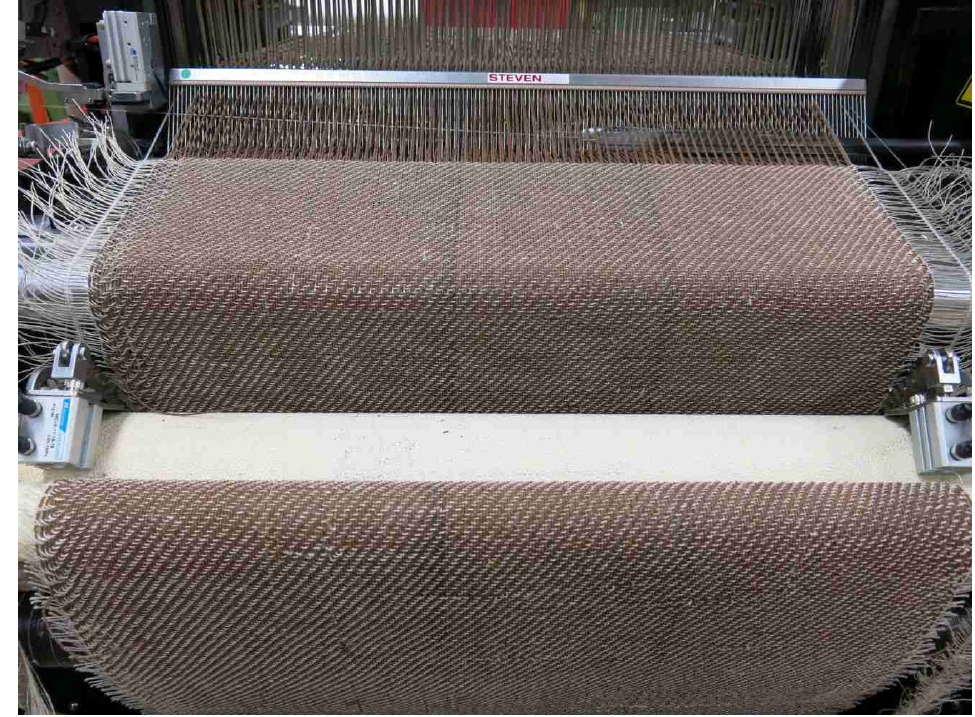
Figure 3. Weaving with FL-LI coated yarn (warp) and FL commercial yarn (weft). Table 4. Weaving parameters.